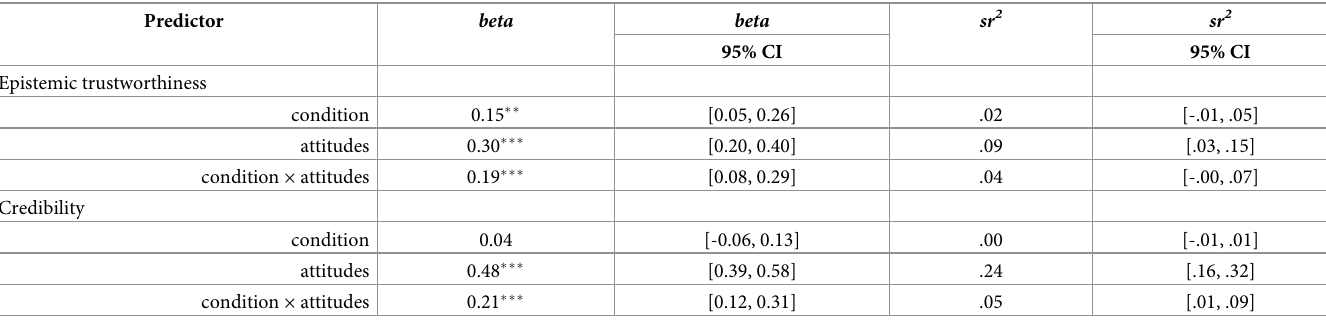
Table 2. Standardized regression results and semi-partial correlations, Study 1. Predictor